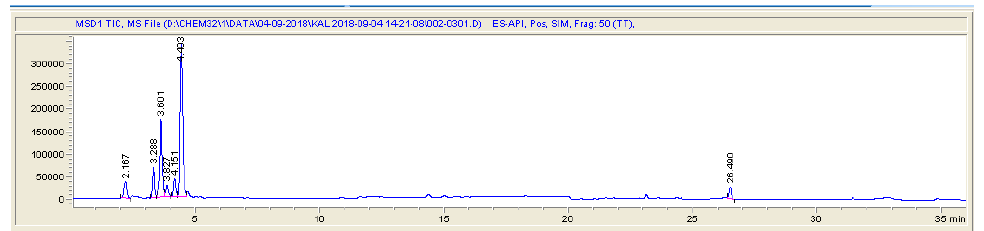
Figure 3. LC ‑ MS (SIM) chromatogram of blank pig feces sample.